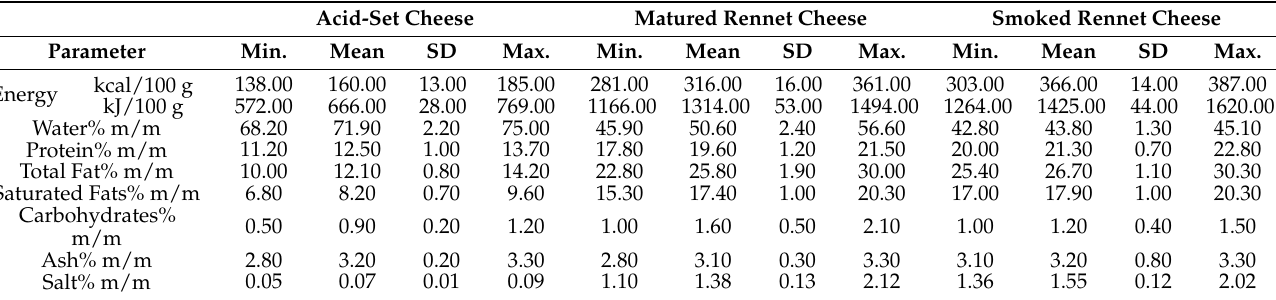
Table 3. Cow’s milk cheeses’ physicochemical